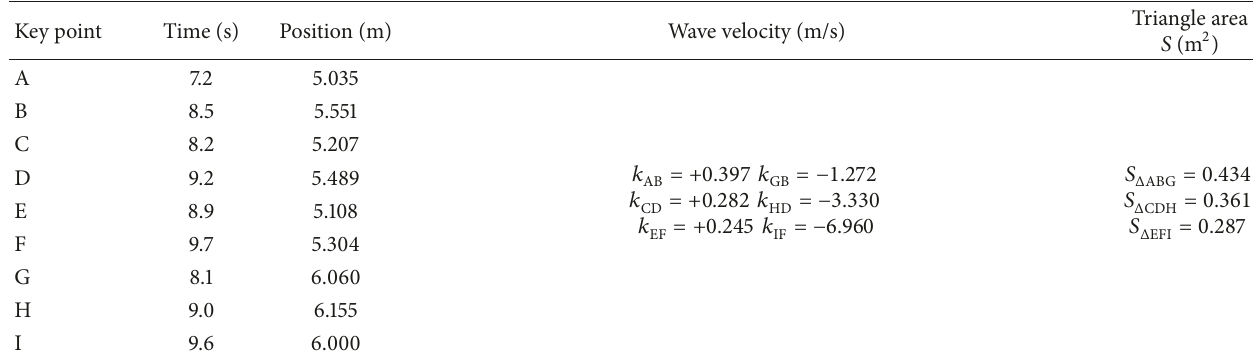
Table 2: Value of the key parameter.